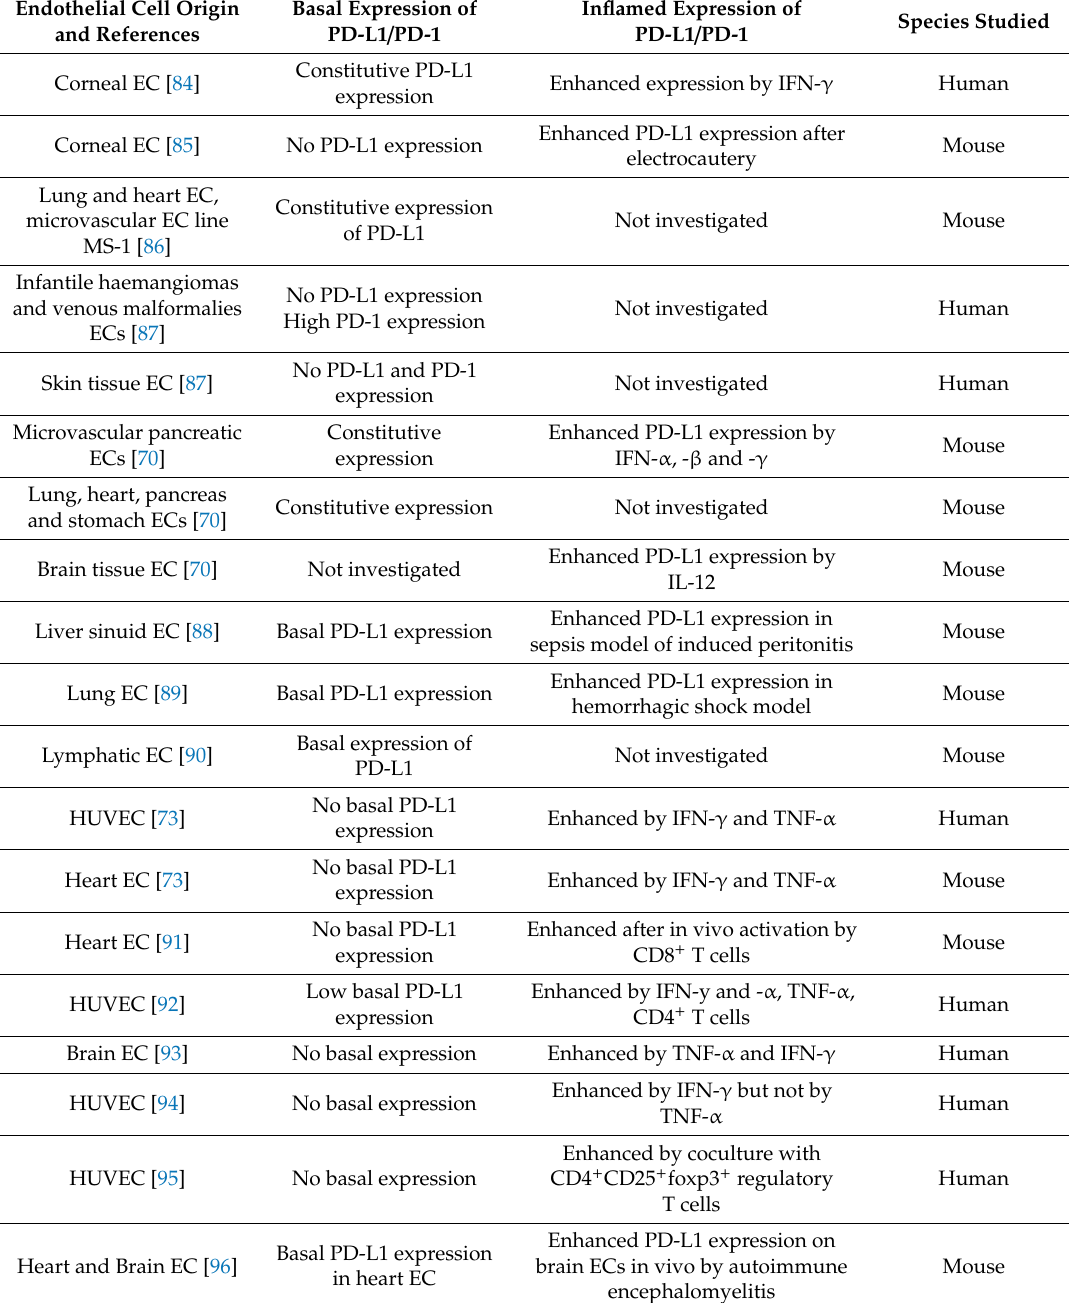
Table 2. Conditional Expression of PD-1 and PD-L1 on di ff erent localized endothelial cells. Endothelial Cell